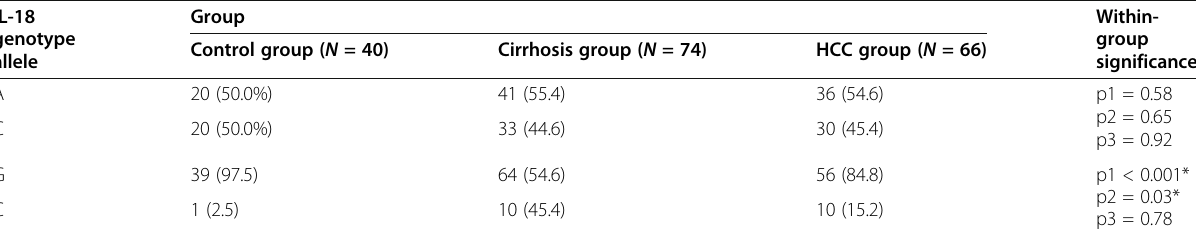
Table 6 Comparison of different IL-18 genotypes alleles in the groups IL-18 genotype